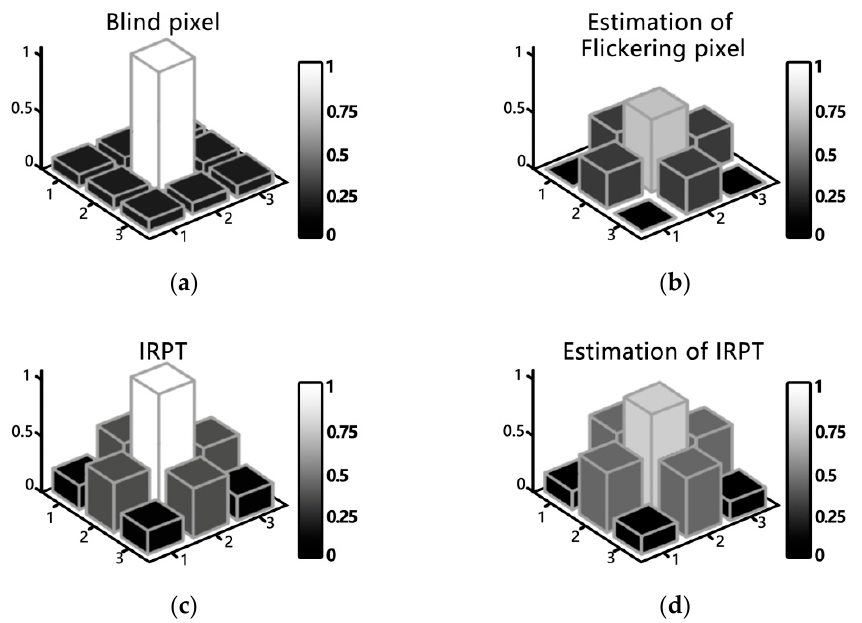
Figure 2. The estimation of facet model ( a ) simulated blind pixel, ( b ) estimation of blind pixel by facet model, ( c ) simulated IRPT, ( d ) estimation of IRPT by facet